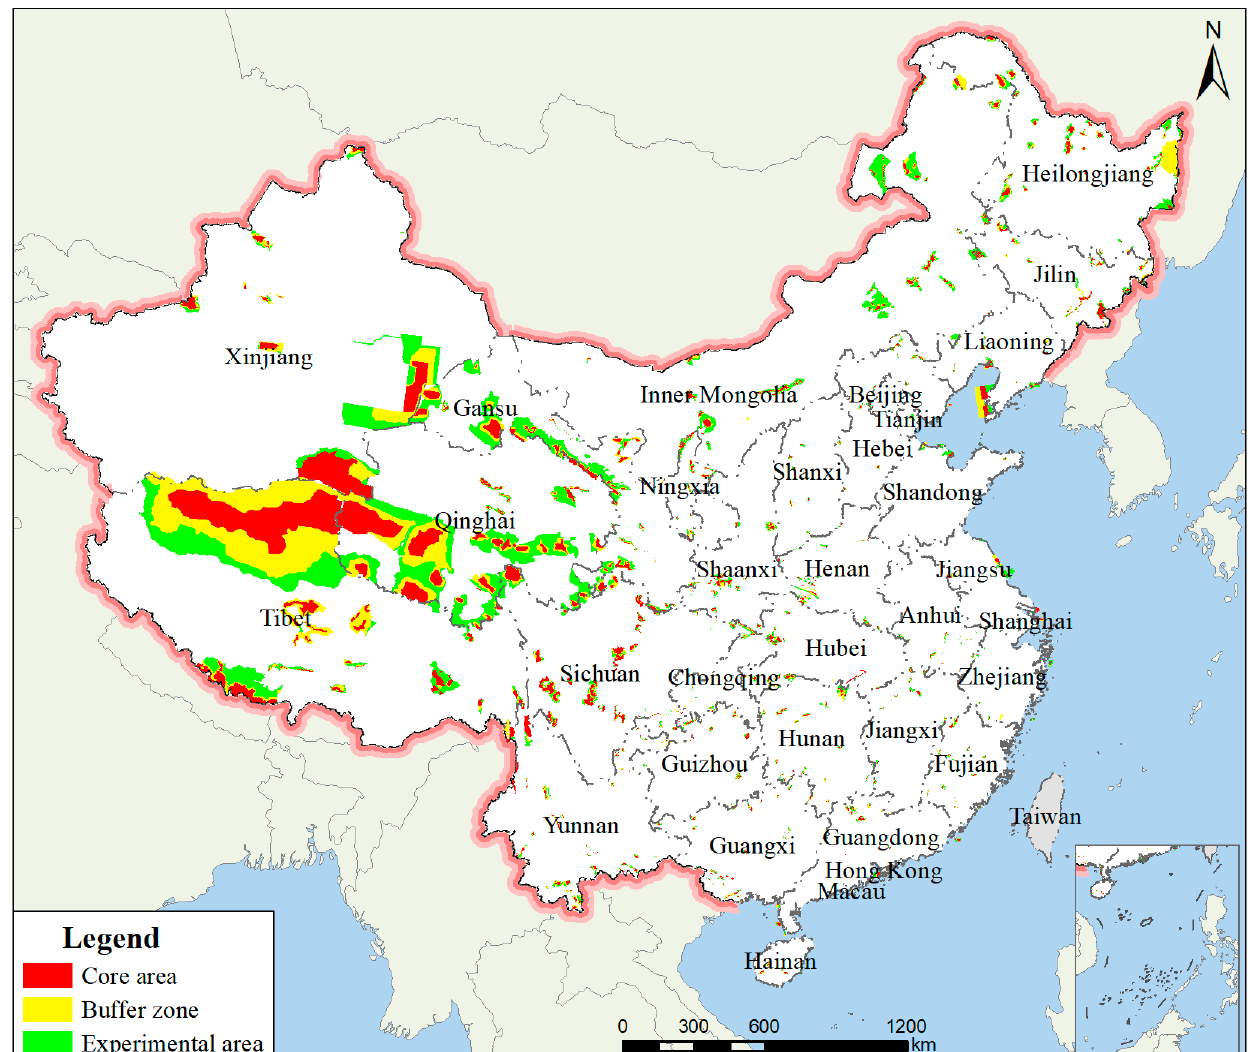
Figure 3. The spatial distribution of national nature reserves in China.